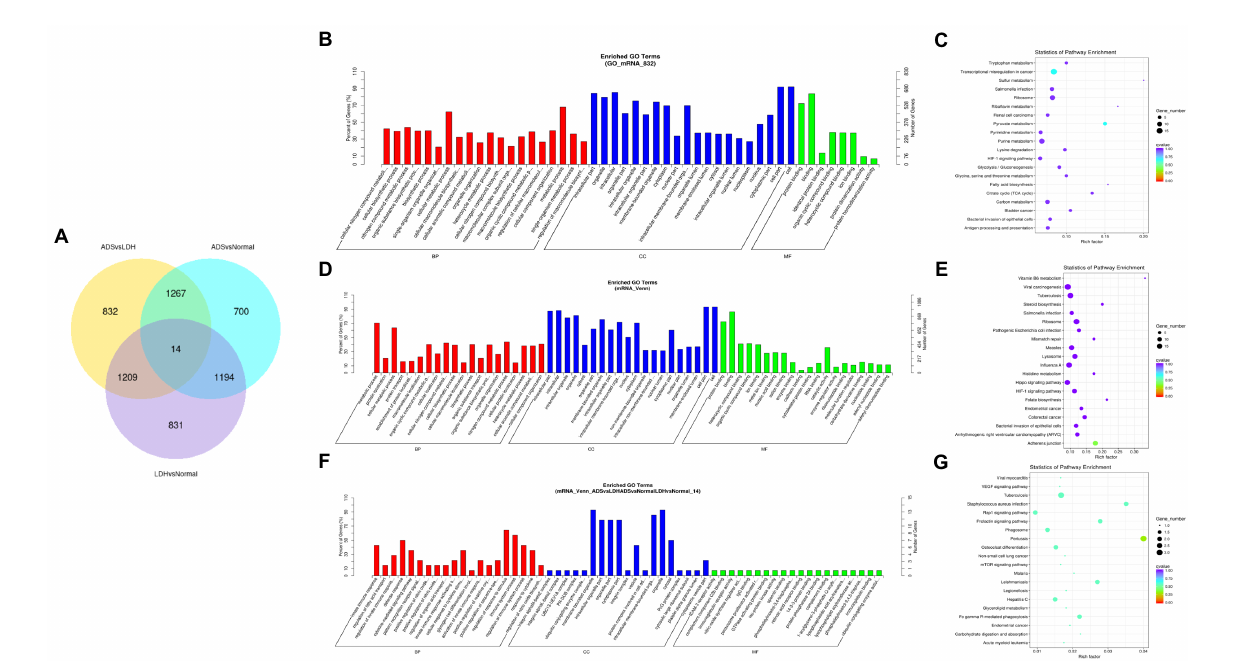
FIGURE 6 Identification of differentially expressed mRNAs combined with the GSE209825 dataset in ADS (A) The Venn diagram created by the differentially expressed data of mRNAs was combined with the GSE209825 dataset. (B) The 20 most enriched Gene Ontology terms for the parental genes of 832 significantly DE mRNAs in the ADS compared to the LDH group. (C) The 20 most enriched KEGG pathways for 832 significantly DE mRNAs. (D) The 20 most enriched Gene Ontology terms for the parental genes of 1,267 co-significantly DE mRNAs in the ADS compared to the LDH and Normal group. (E) The 20 most enriched KEGG pathways for 1,267 significantly DE mRNAs. (F) The 20 most enriched Gene Ontology terms for the parental genes of 14 co-significant DE mRNAs. (G) The 20 most enriched KEGG pathways for 14 co-significantly DE mRNAs. Enriched GO terms are on the vertical axis, and the number of annotated differentially expressed genes associated with each GO term is indicated on the horizontal axis. The size of the symbol represents the number of genes, and the colors represent p -value in KEGG.